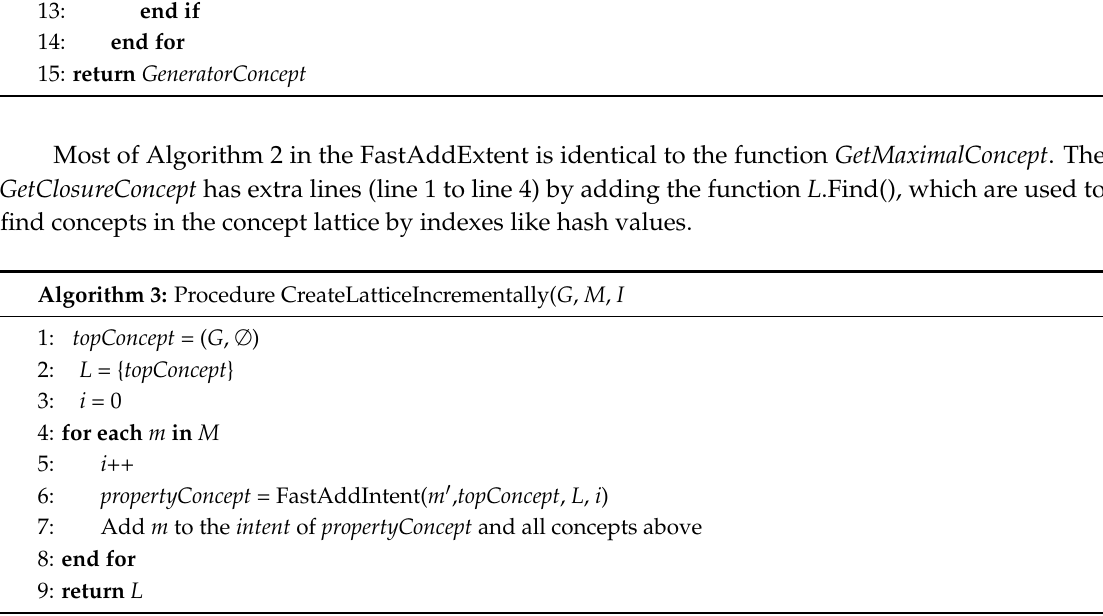
Algorithm 3 is the beginning of the construction of a concept lattice. In Algorithm